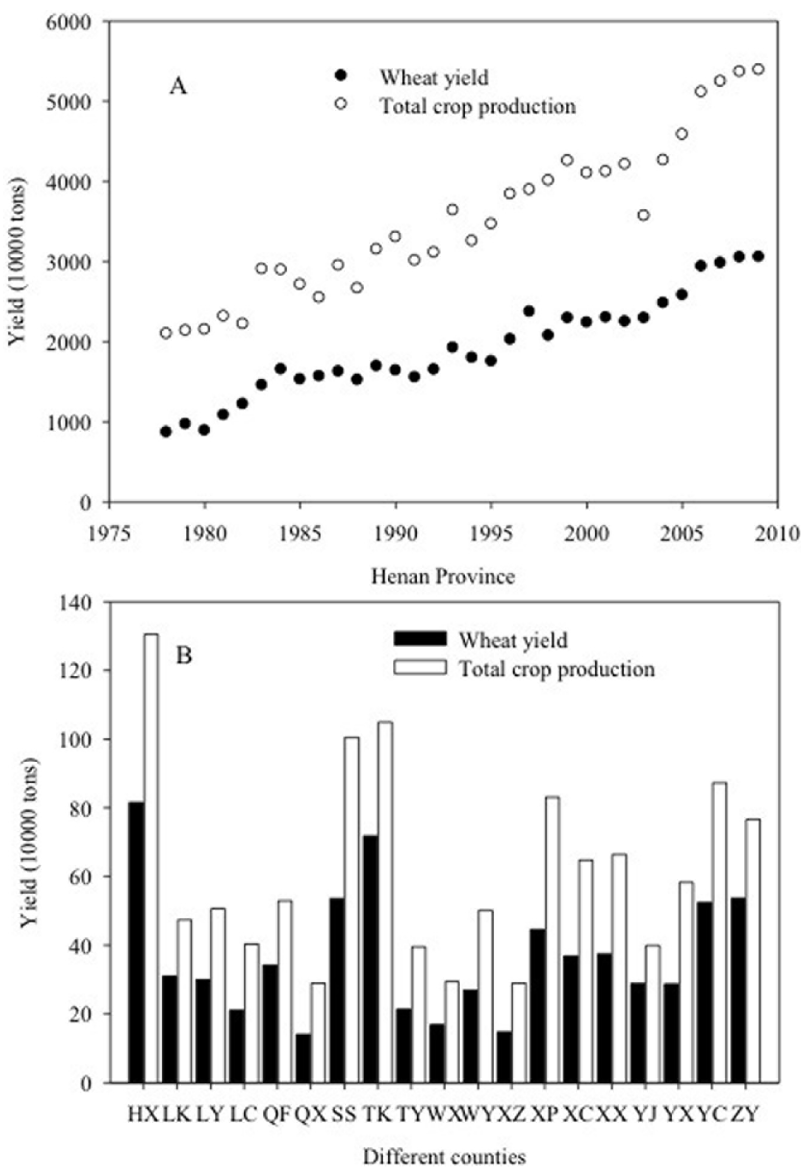
Figure 3. Wheat yield and total crop production (including wheat, maize, millet,) in Henan Province from 1978–2009 (A), and wheat yield and total crop production in different counties within Henan Province in 2009 (B). See Table 1 for key to county name abbreviations.